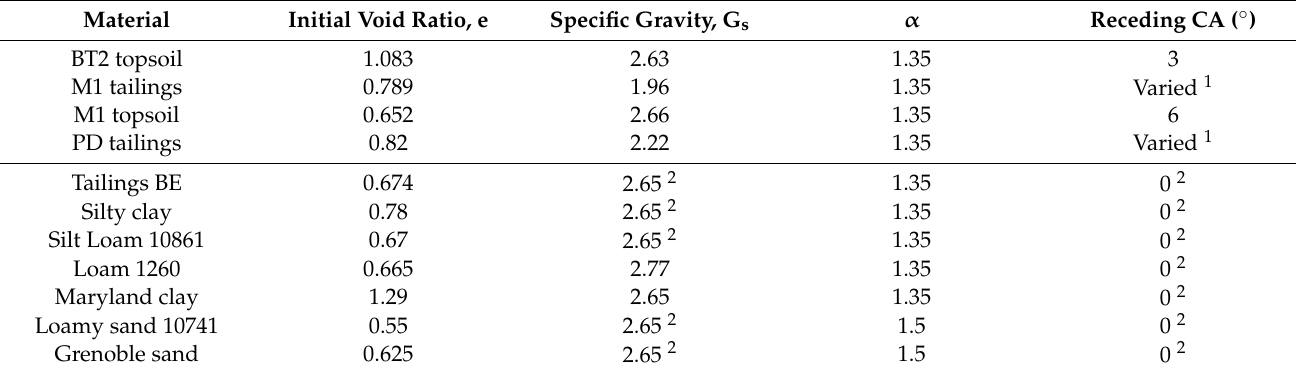
Table A4. Parameters used in the Arya-Paris model (AP) for each material: initial void ratio, specific gravity, parameter α , and receding contact angle (CA).